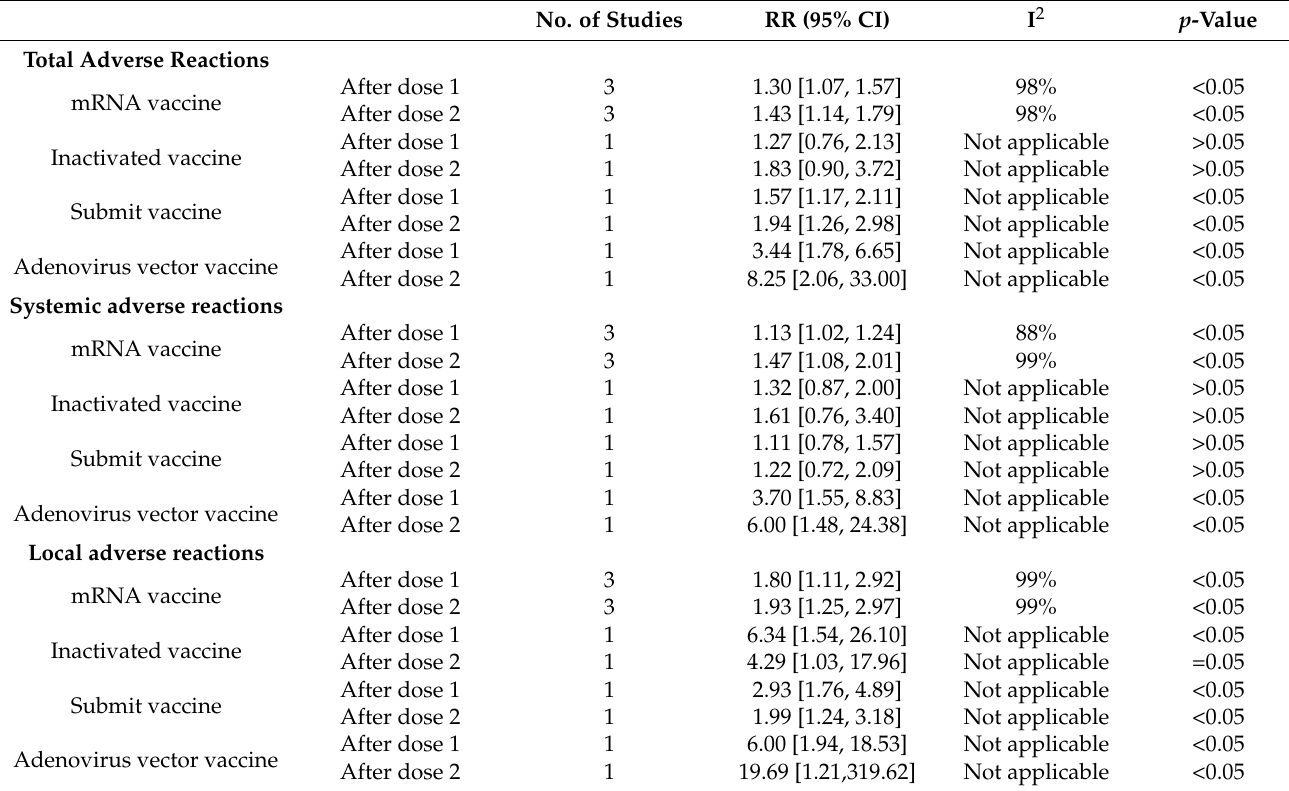
Table 3. All adverse reactions in the vaccination group versus the control